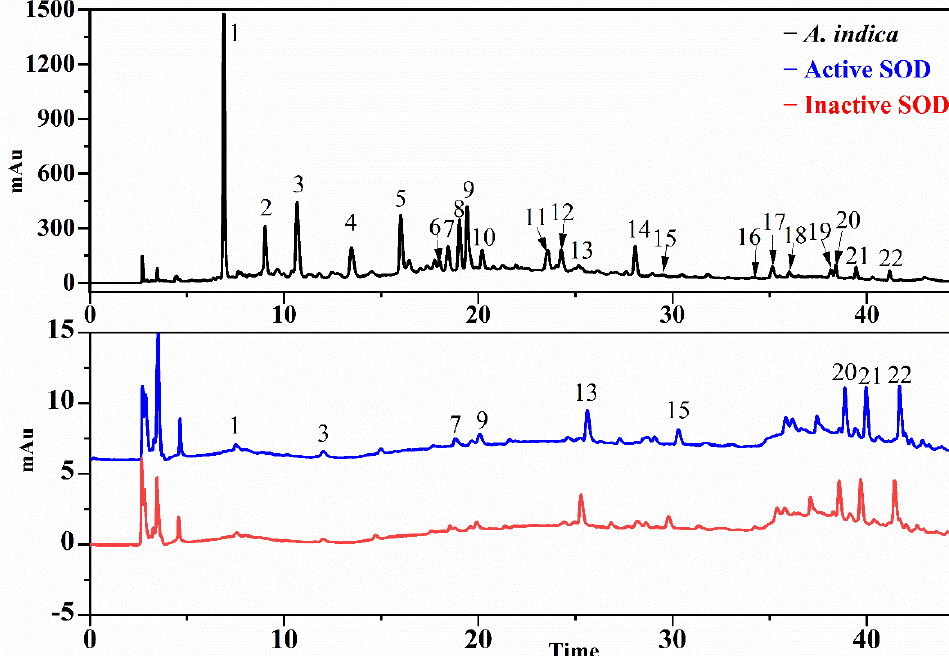
Figure 3. The UF-LC-UV chromatograms of EA fraction from A. indica with superoxide dismutase (SOD) at 280 nm. The black line represents the HPLC profiles of EA fraction, the blue and red line represent activated and inactivated SOD, respectively.